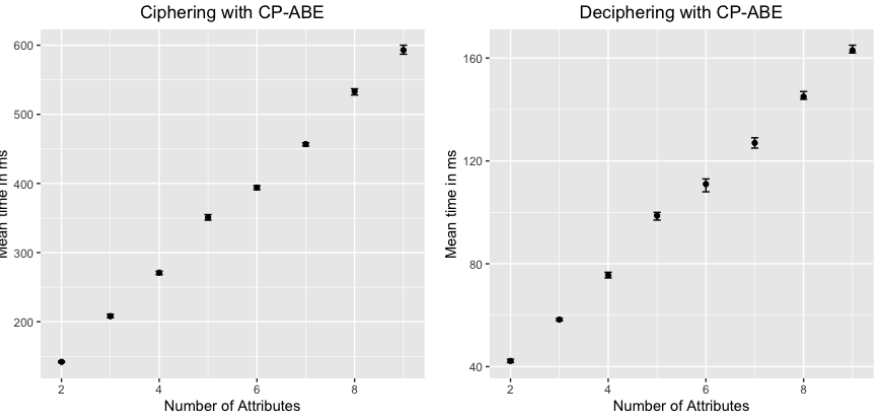
Figure 5. Encryption and Decryption time of